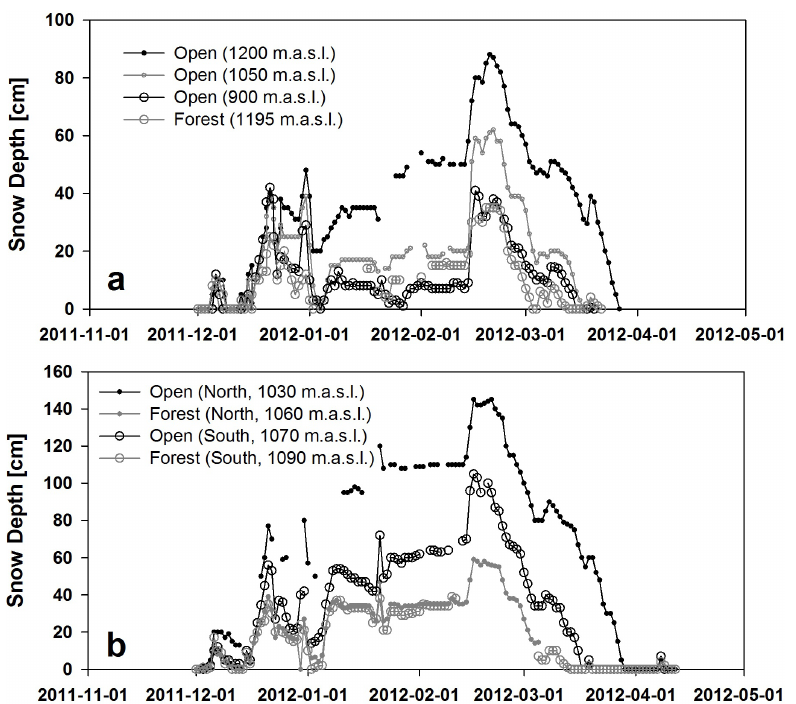
Fig. 6. Snow depths dynamics at 8 locations in the Brugga catchment (a) and the Breg catchment (b) in the winter season 2011/2012 derived from the digital